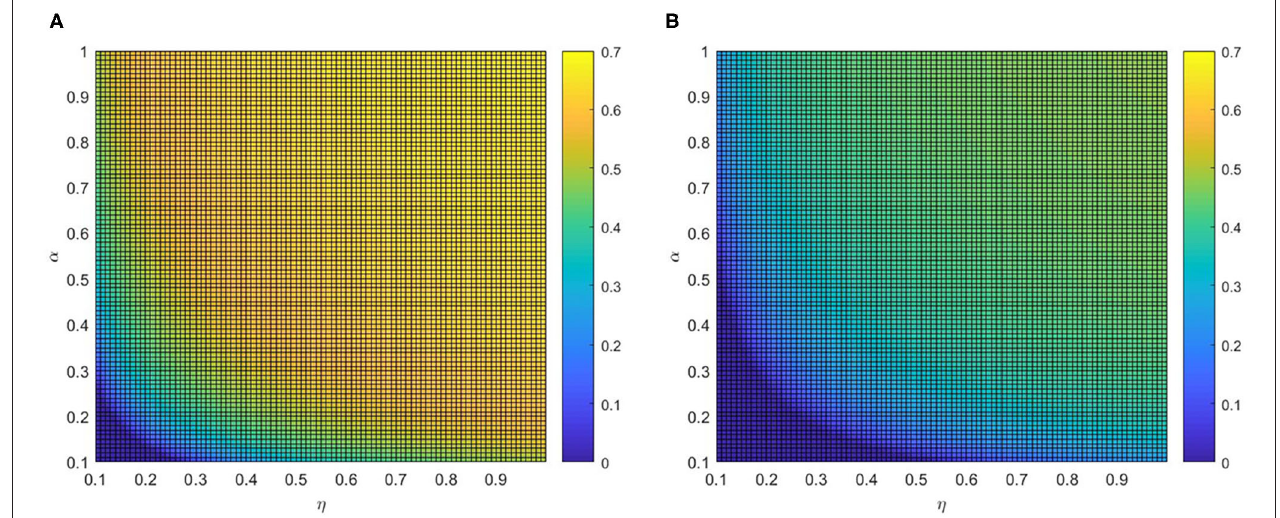
FIGURE 9 | The fraction ρ V of vaccinated individuals in the stationary state, where ε = 0.05, λ = 0.2 and ρ = 0.05. (A) δ = 0.2 and (B) δ =